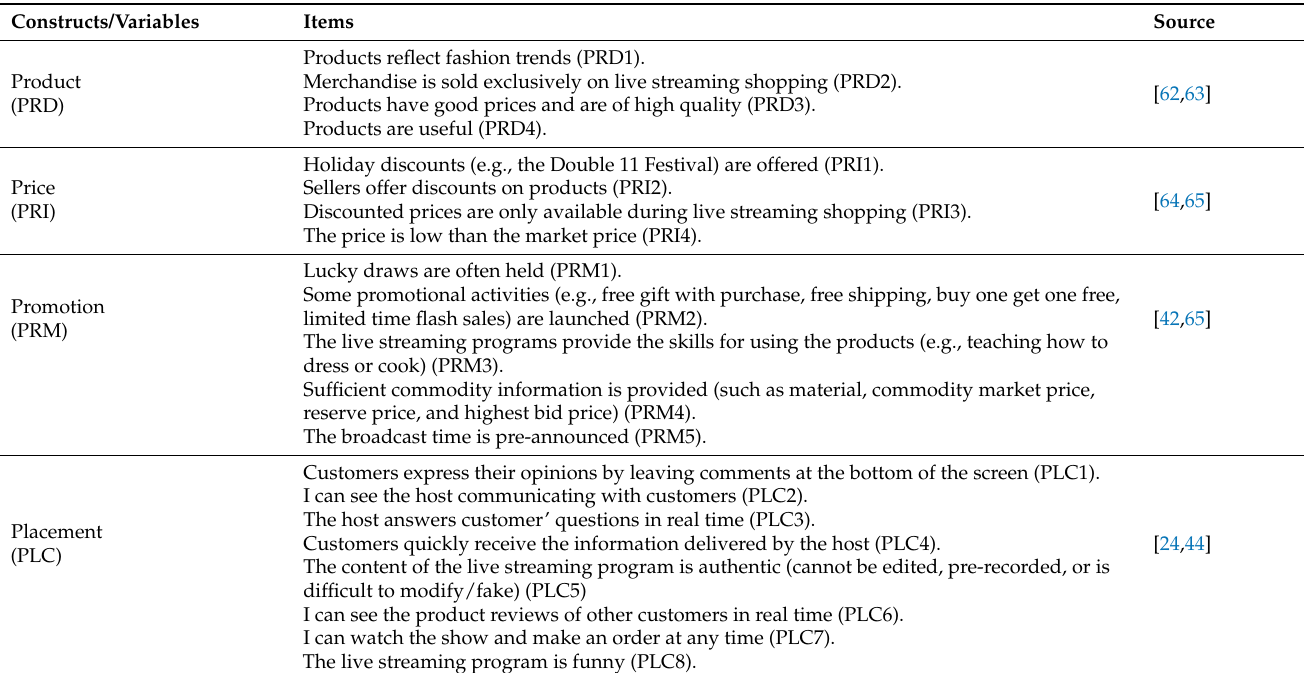
Table A1. Measurement Items in the Research